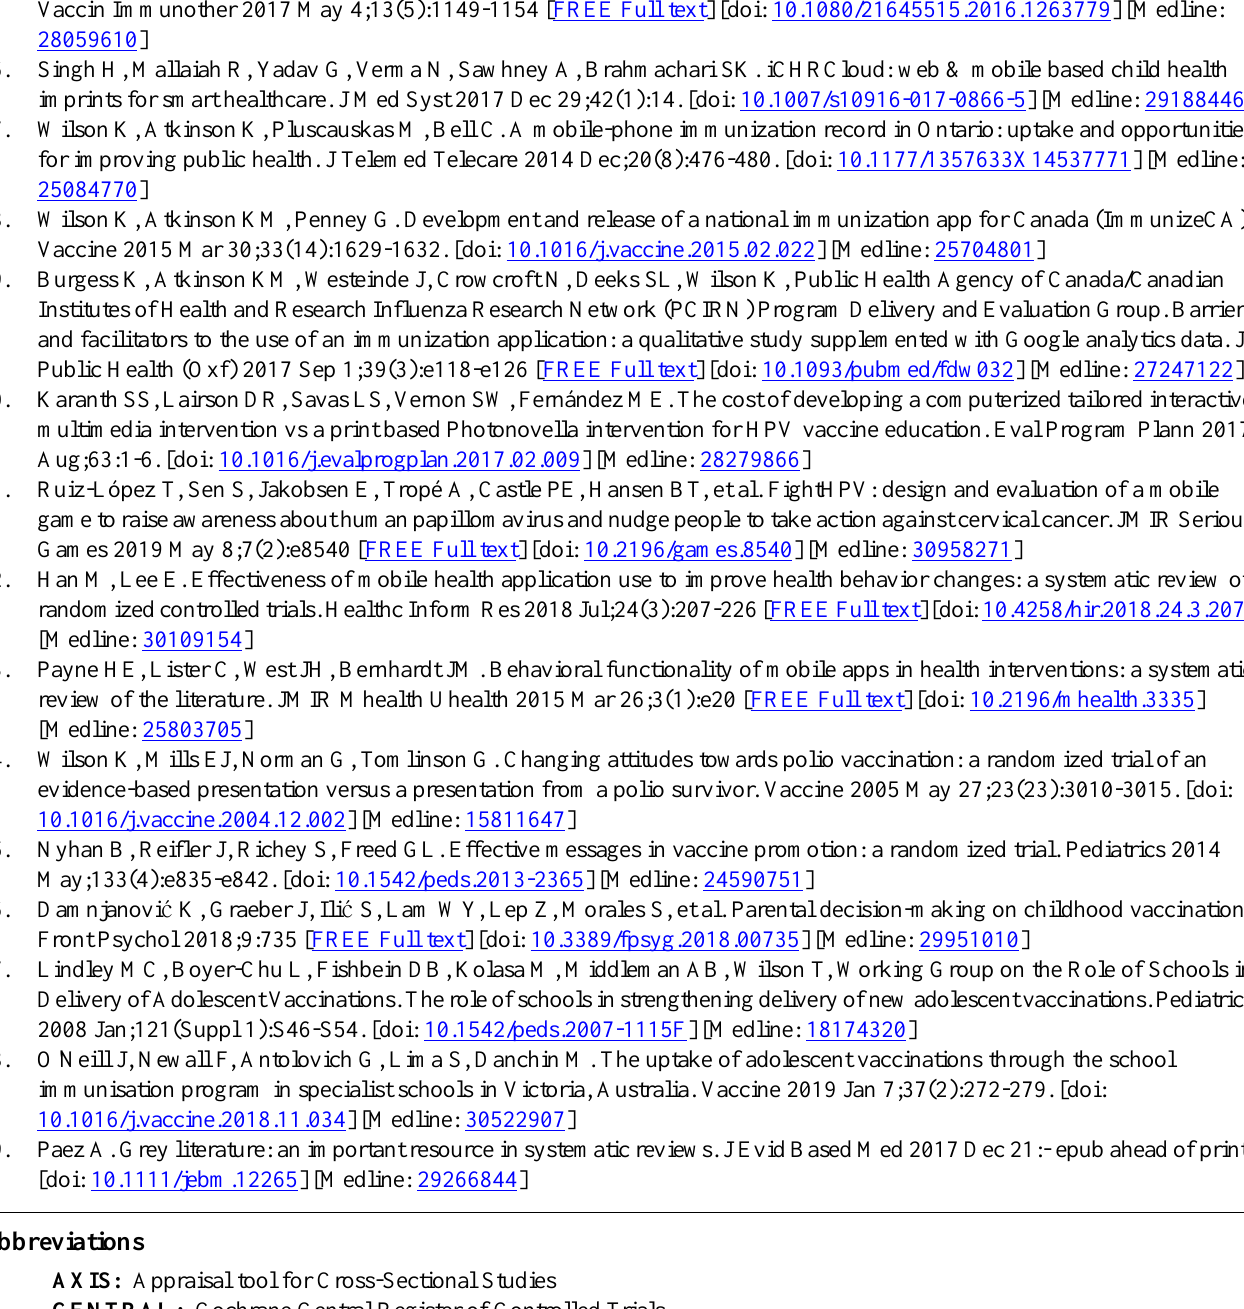
Abbreviations AXIS: Appraisal tool for Cross-Sectional Studies CENTRAL: Cochrane Central Register of Controlled Trials EPI: Expanded Program on Immunization ERIC: Education Resources Information Center HPV: human papillomavirus MeSH: Medical Subject Headings mHealth: mobile